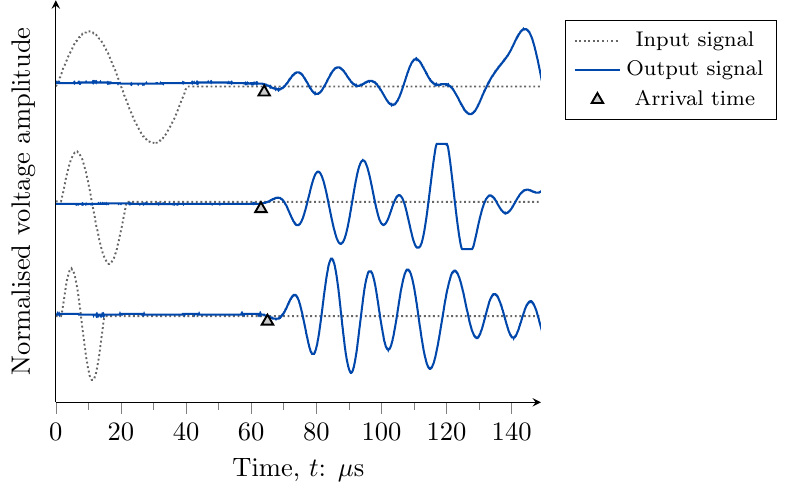
Figure 5. Typical signals of P-wave during triaxial testing (Test 1, t t